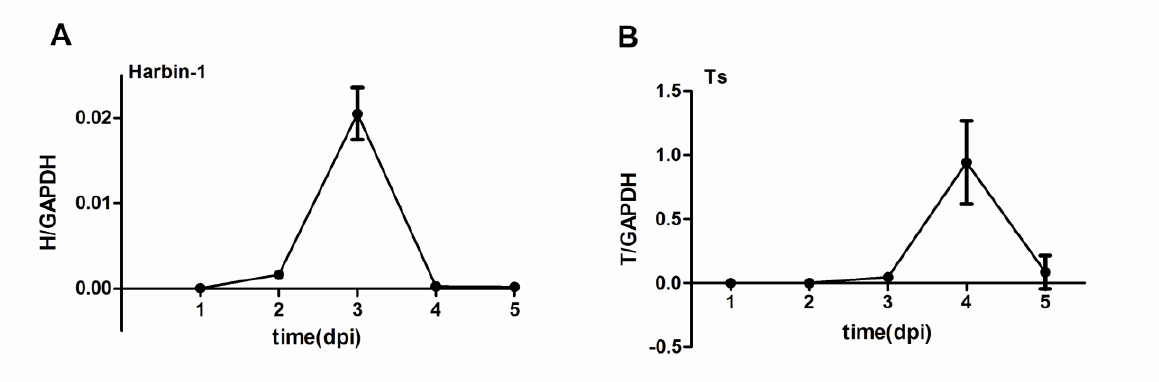
Figure 2. Vp2 mRNA levels in the bursa of Fabricius of SPF chickens infected with the Harbin-1 ( A ) or Ts strain ( B ) of